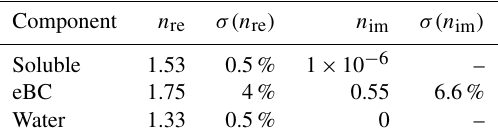
σ ext with Eq. (7) (adapted and modified from Virkkula et al., Table 3. Real ( n re ) and imaginary part ( n im ) of the complex re- fractive index ( n ) of the aerosol components used for the volume- weighted mixing in the algorithm to derive n of the core and the shell of the aerosol particles. Also the SD ( σ ) of each part of n is given in which the algorithm varies the n of each compound to pro- vide a possible range of values for σ ext and σ bsc . The values in this table where taken out of Ma et al.